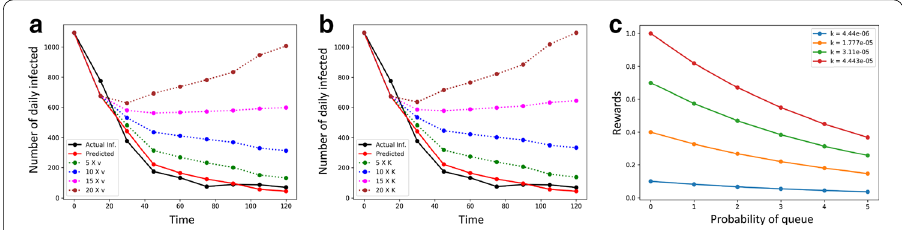
Fig. 3 The effects of a average velocity v and b contact index k on the daily infected numbers; c rewards for different probability of queue ( p queue ) and contact index